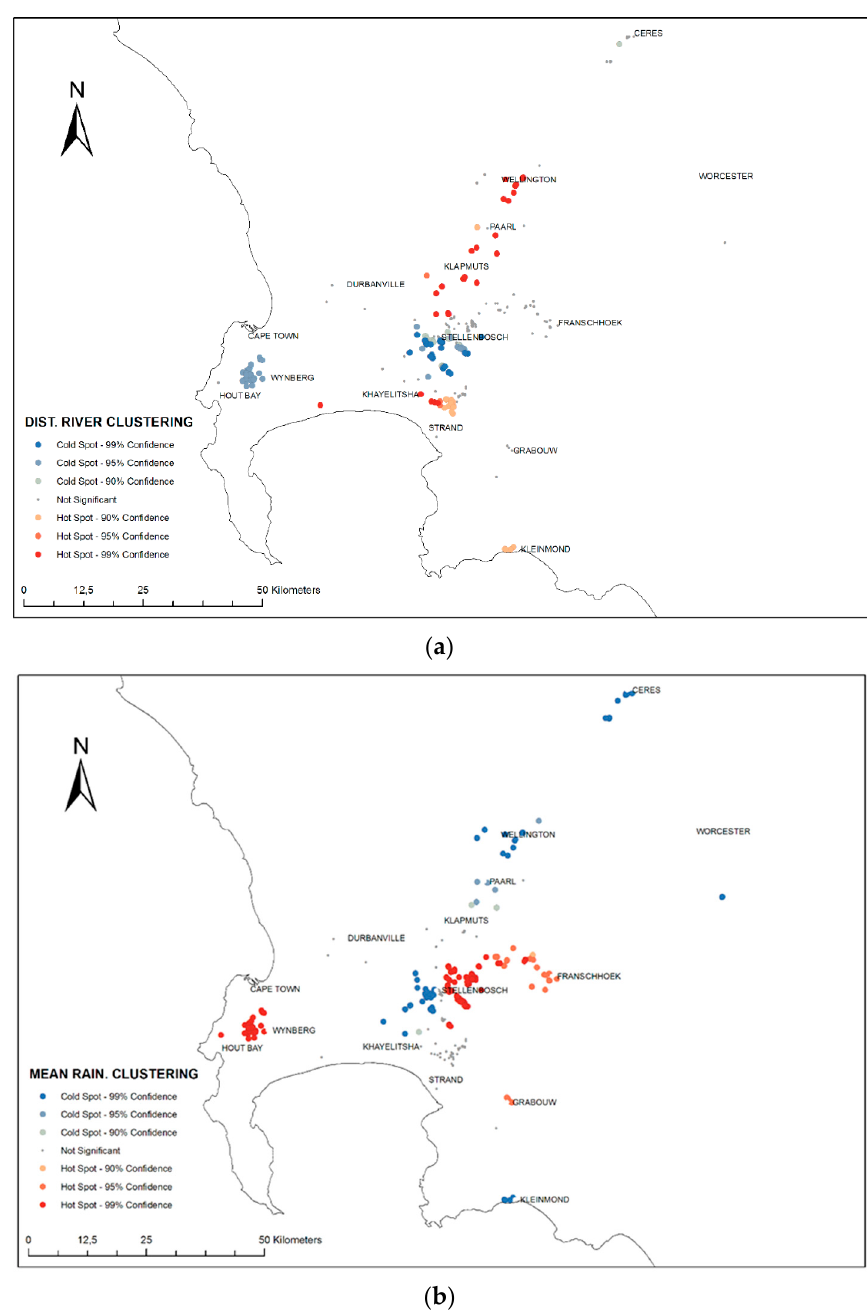
Figure 4. Optimised Hot Spot Analysis maps of ( a ) ‘distance to a main river’, and ( b ) mean annual rainfall for all sampled V. germanica nests. A hotspot (red) means significant clustering of high values of the analysed environmental variable, while a cold spot (blue) shows significant clustering of low values (and not clustering of the nest records themselves).